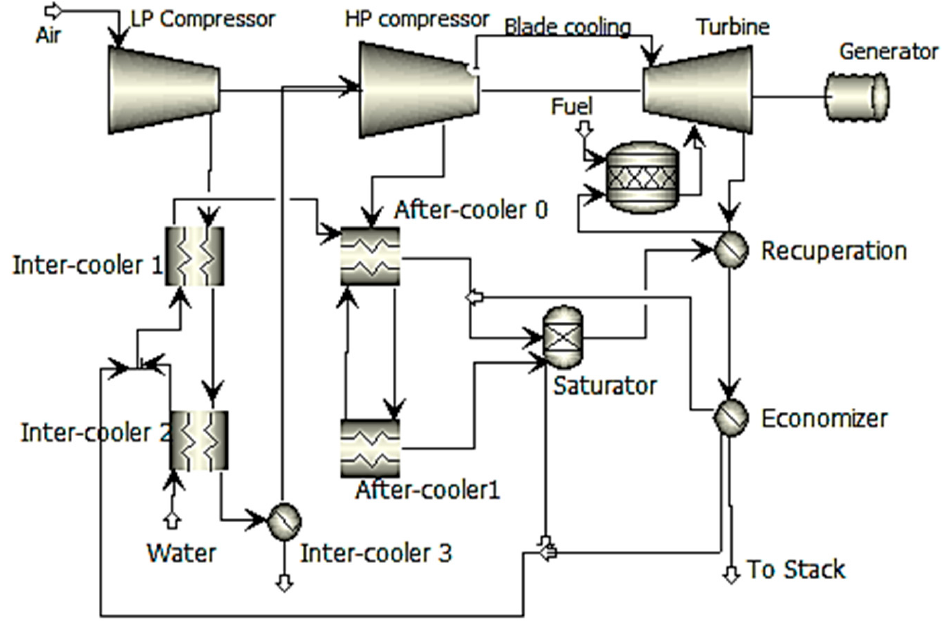
Figure 6. Cycles of inter-cooled humid air conceptual plant diagram (HAT).